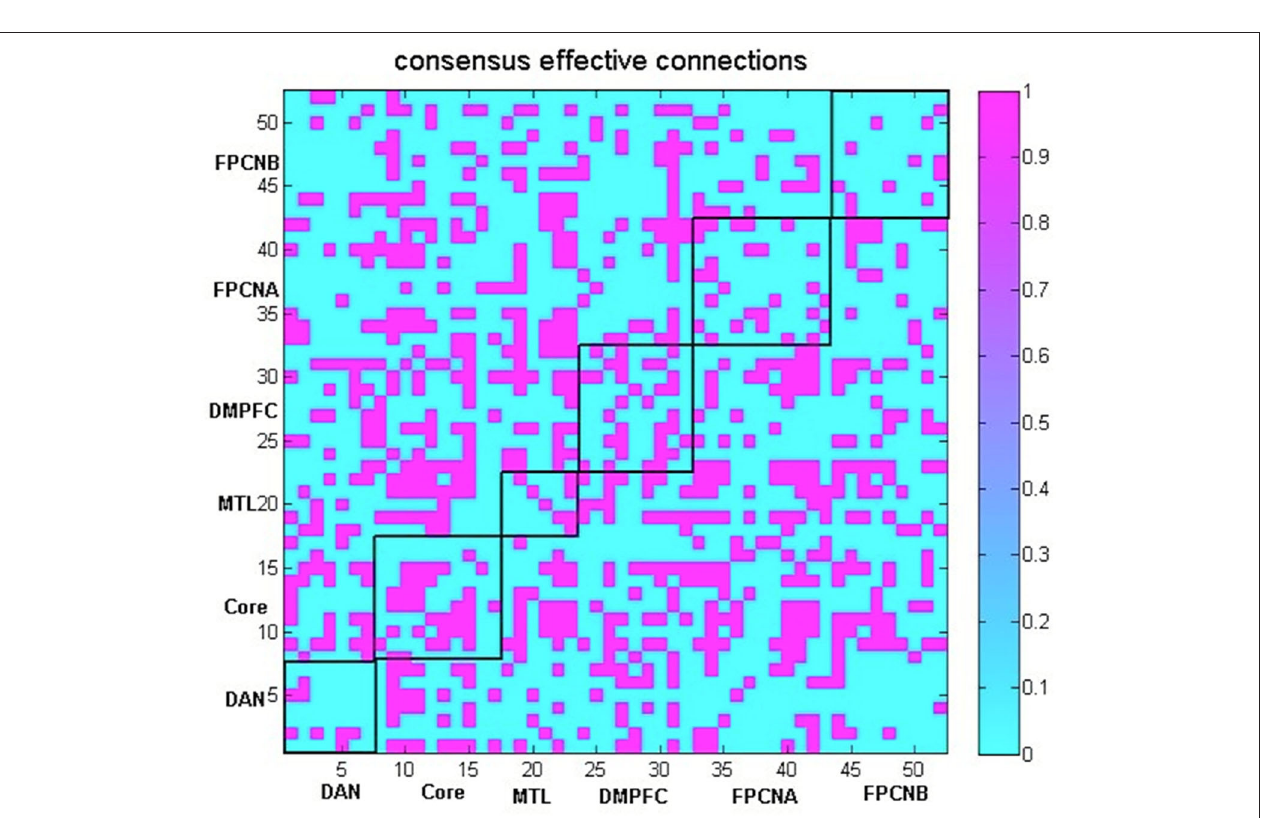
FIGURE 3 | The consensus effective connections within or across the MTL subsystem, DM subsystem, Core, FPCNA subsystem, FPCNB subsystem and DAN (indicated by a 0 or 1).